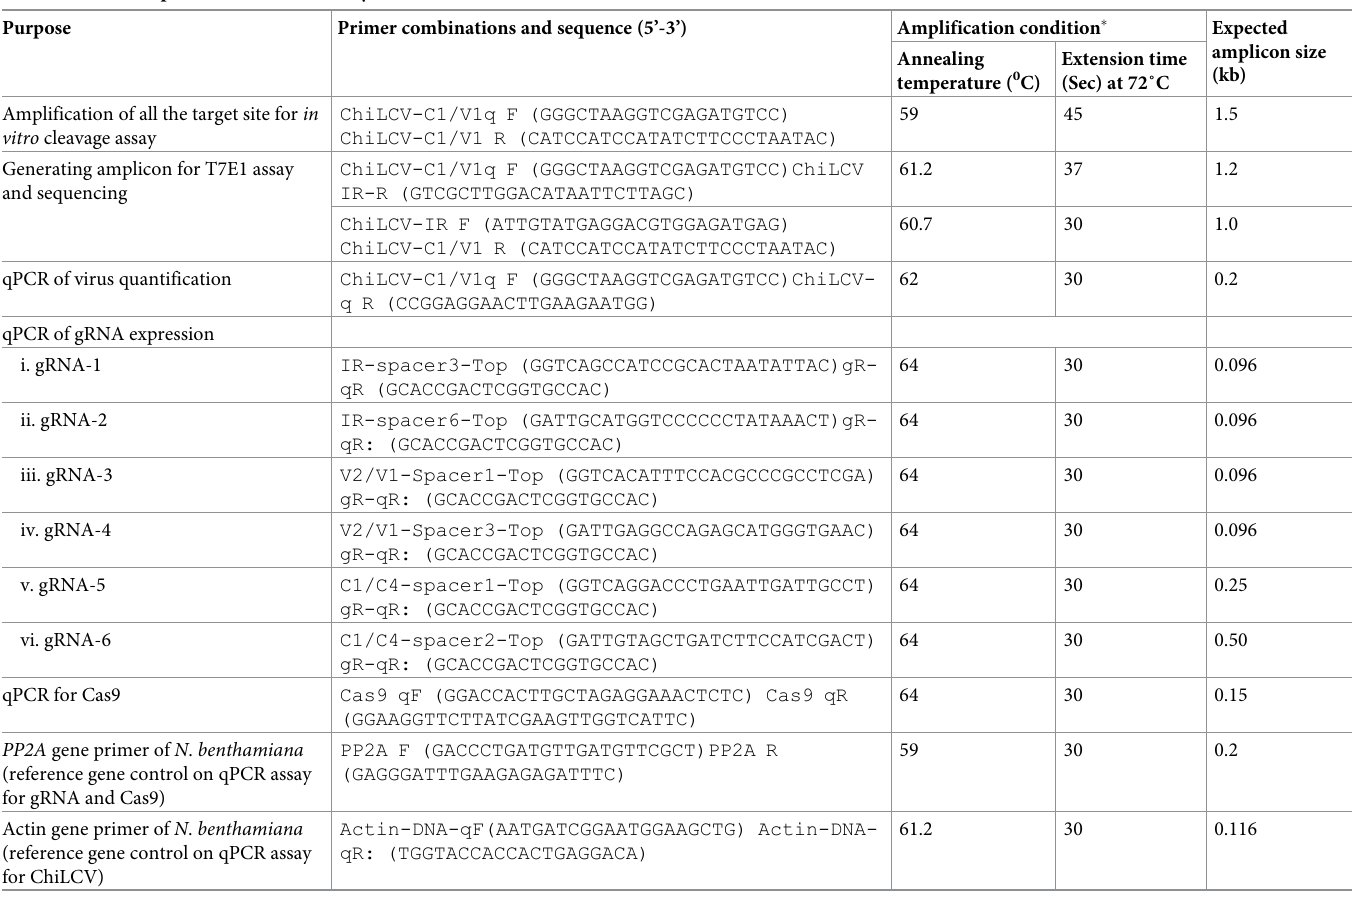
Table 2. Details of primers used in the